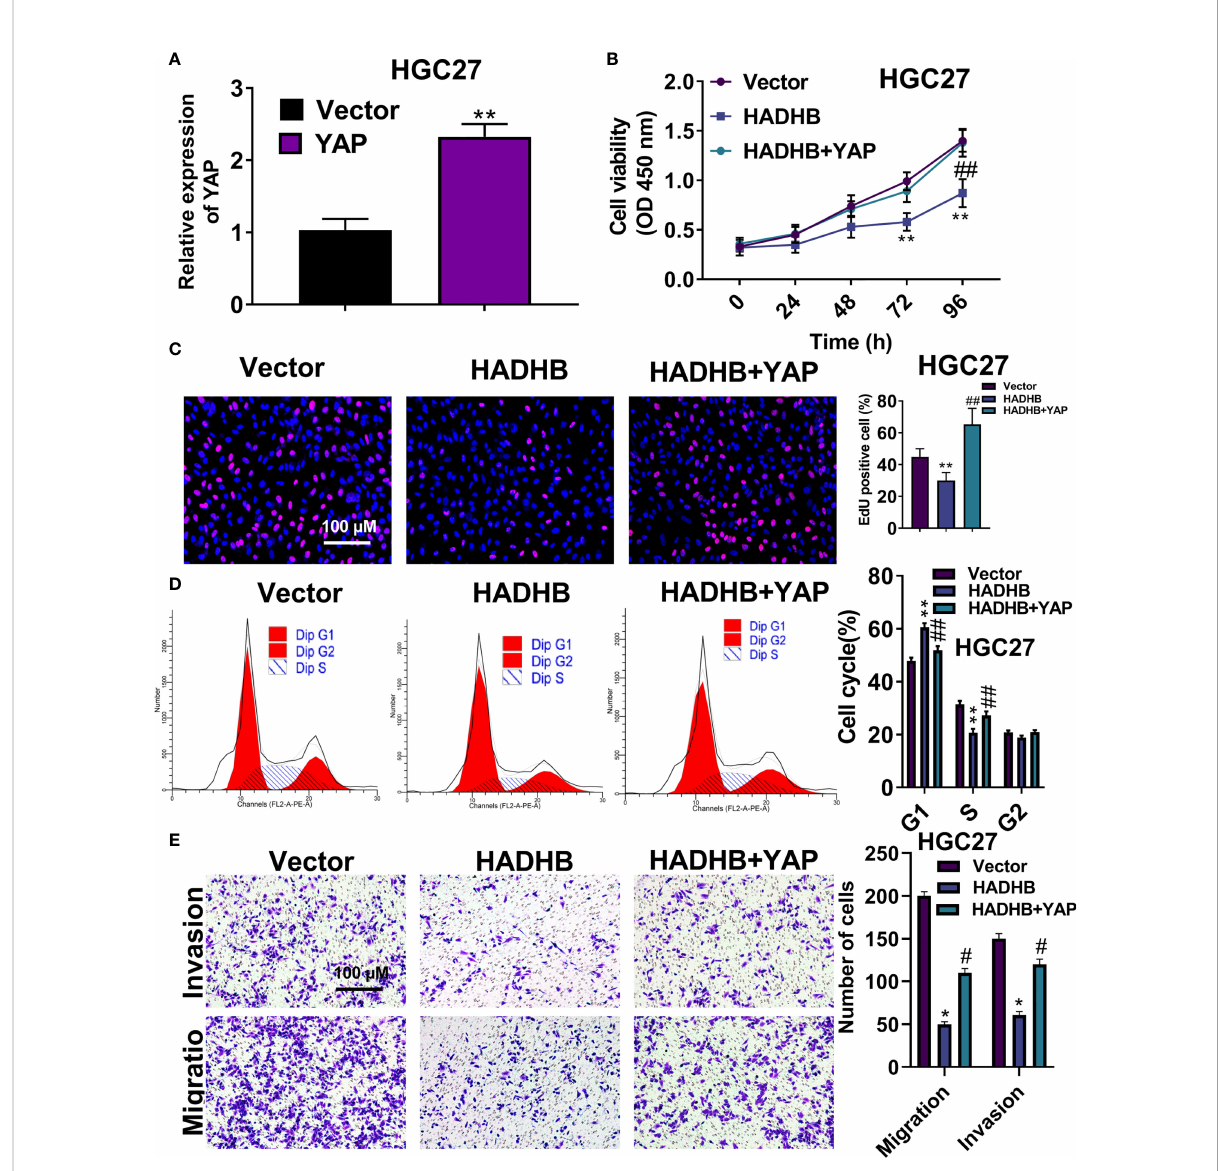
FIGURE 7 YAP upregulation effectively reversed the HADHB upregulation-induced tumour suppressing effects in HGC27 cells (A) . YAP expression in pcDNA3.1-YAP transfected HGC27 cells was measured using qRT-PCR. (B – E) . The viability, proliferation, cell cycle progression, migration, and invasion of the transfected HGC27 cells were determined using the CCK-8 assay, EdU assay, fl ow cytometry analysis, and transwell assay, respectively. * P < 0.05, ** P < 0.01, # P < 0.05, ## P <